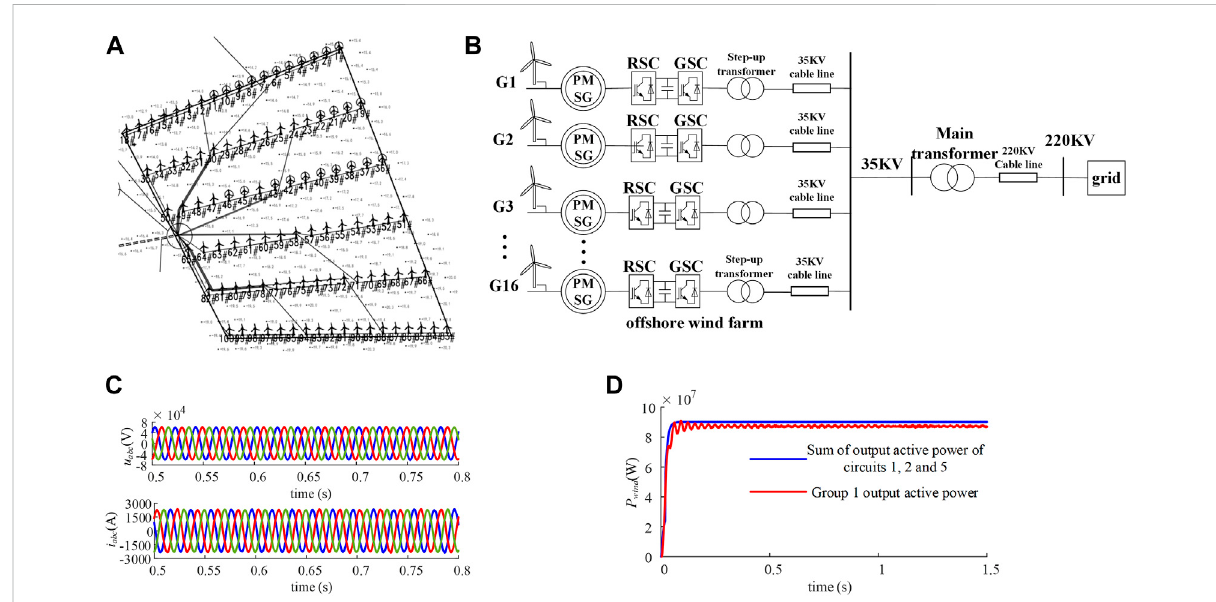
FIGURE 8 Wind farm equivalent simulation. (A) shows connection schematic of the actual wind farm as a model reference for the subsequent wind farm simulation in thispaper. (B) shows structure of thewind farm after classi fi cation and aggregation, taking into account thewind speed conditions and geographical location. (C,D) analyze the waveforms of wind farm grouping 1, and the effectiveness of the equivalence strategy of this paper to improve the capacity-weighting method is veri fi ed by the comparative analysis of grid-connected voltage and current and output power.